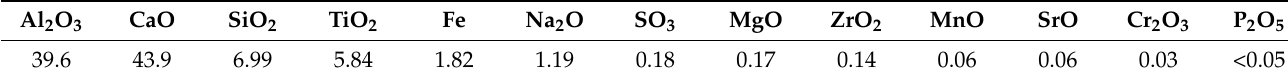
Table 1 . XRF quantitative analysis of bauxite residue and by-product (wt%) .